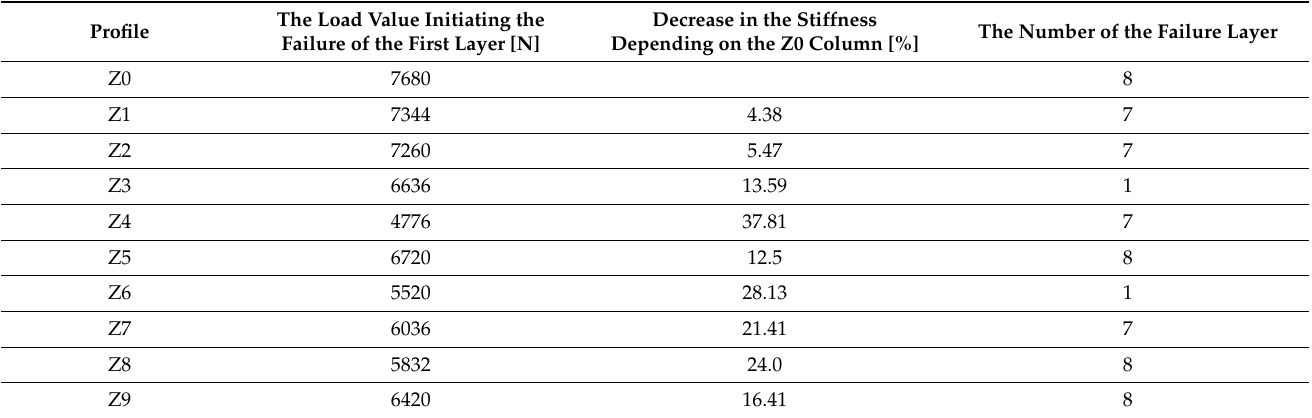
Table 4. The value of the load initiating the failure of the first layer, along with its number and the percent of decrease in the stiffness depending on the Z0